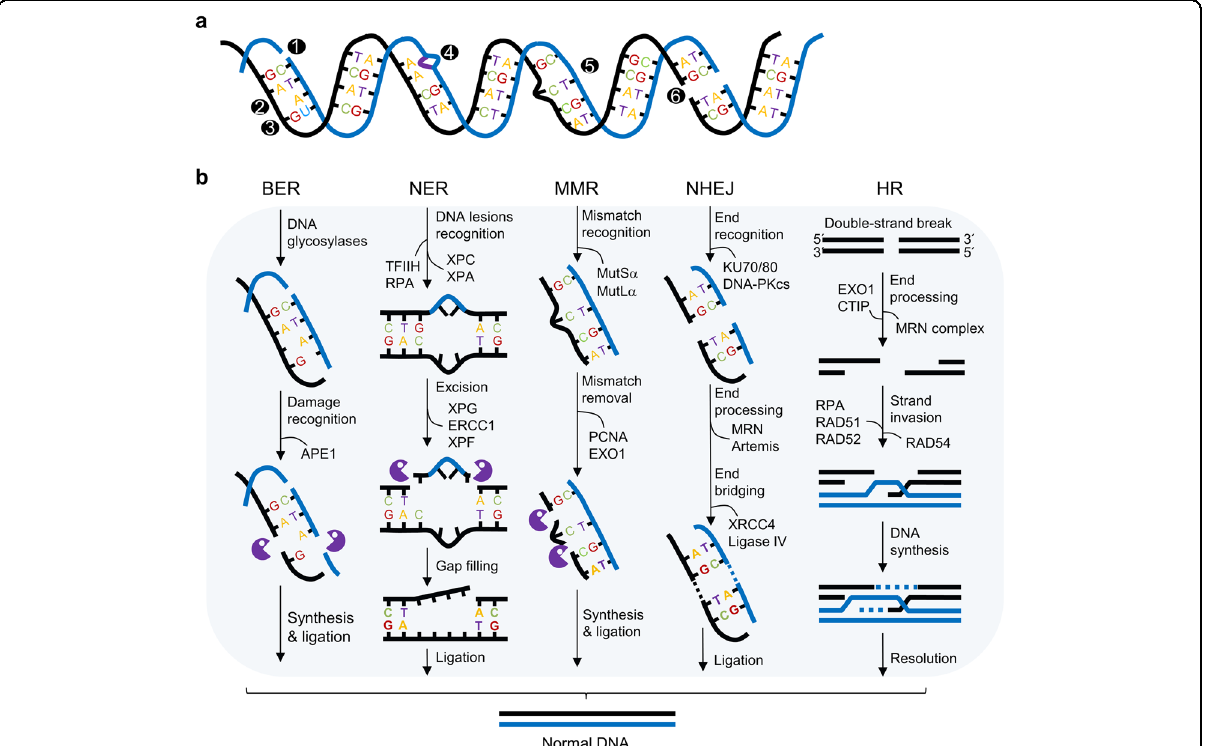
Fig. 2 Molecular pathways of DNA repair. a DNA damage. (1) Single-strand breaks (SSBs), (2) apurinic/apyrimidinic (AP) sites, (3) deaminations, (4) T-T dimers, (5) DNA mismatched pairs (base to base), and (6) double-strand breaks (DSBs). b DNA repair processes. Various types of DNA damage can be repaired by base excision repair (BER), nucleotide excision repair (NER), mismatch repair (MMR), nonhomologous end joining (NHEJ) and homologous recombination